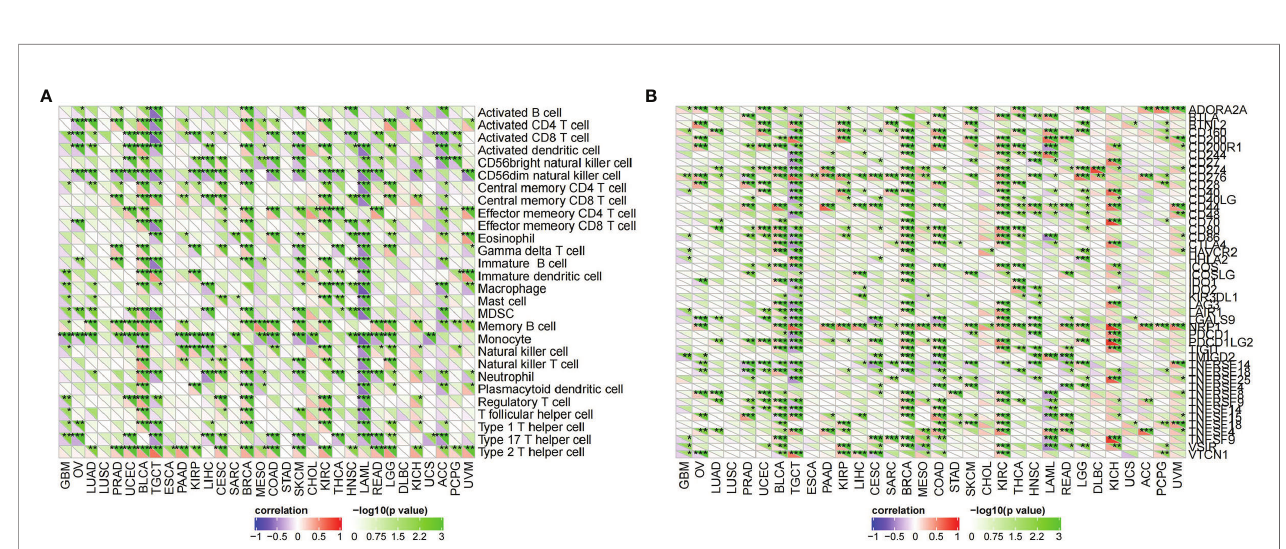
FIGURE 7 | Correlation of T. hemsleyanum -targeted protein CDK6 with immunity in pan-cancer. (A) Analysis of tumor immune cell in fi ltration. (B) Correlation analysis of immune checkpoints. *p < 0.05, **p < 0.01, ***p <